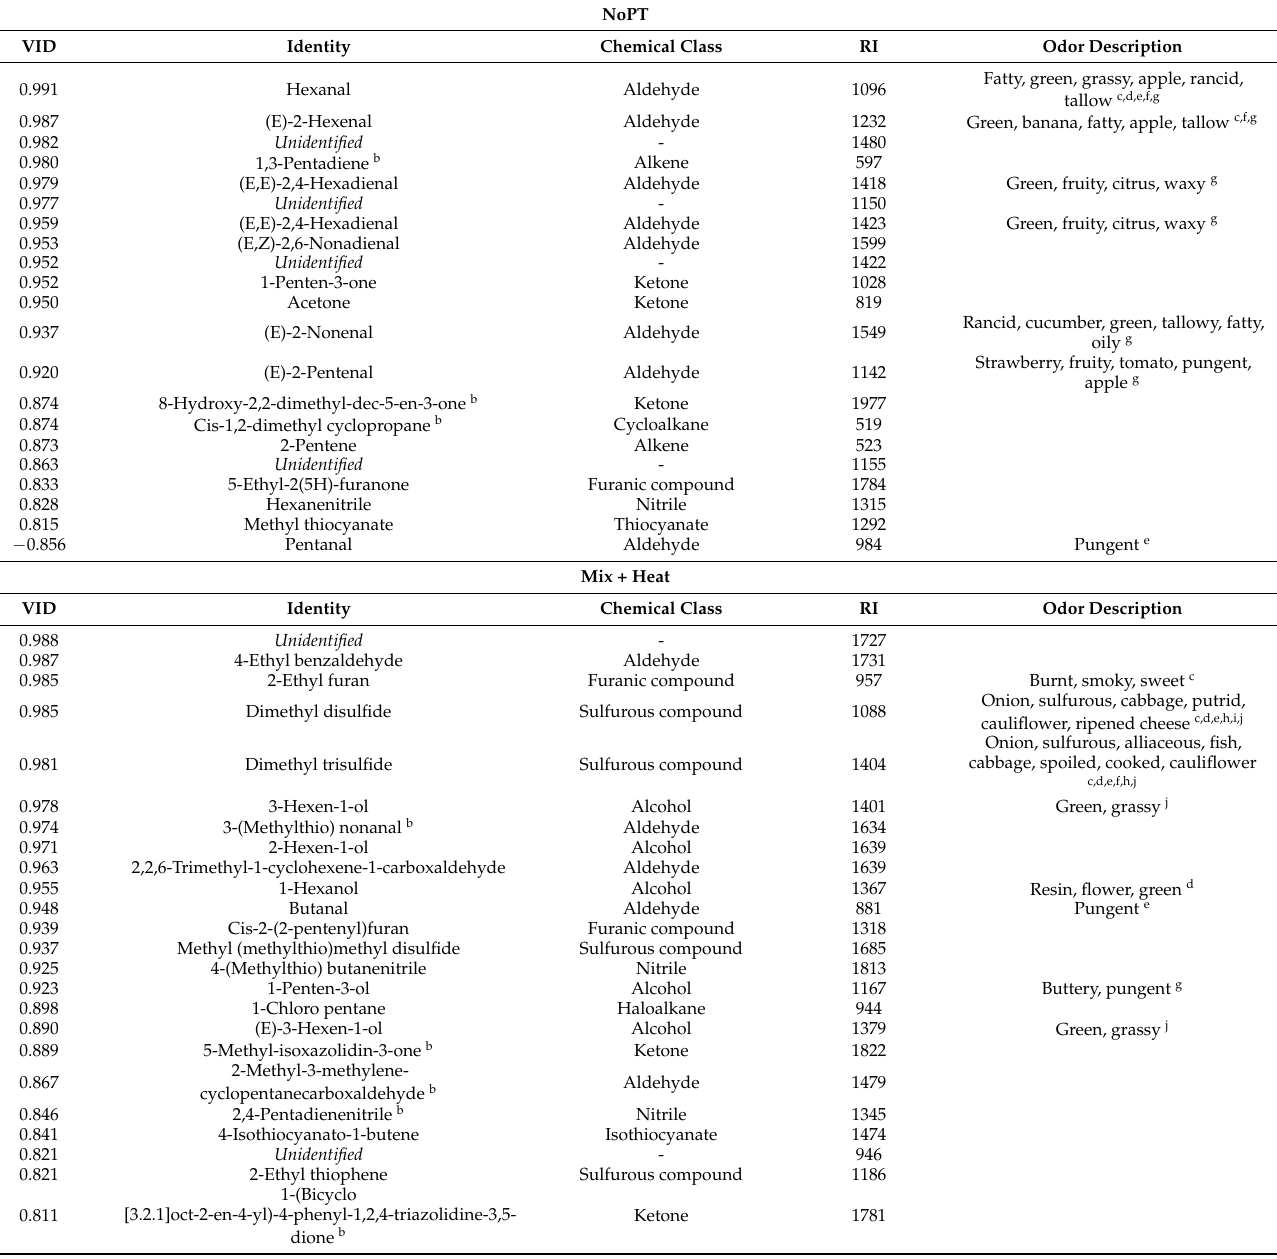
Table 2. VID, identity, chemical class and RI of markers (|VID| ≥ 0.800) for differently pretreated Brussels sprouts samples a